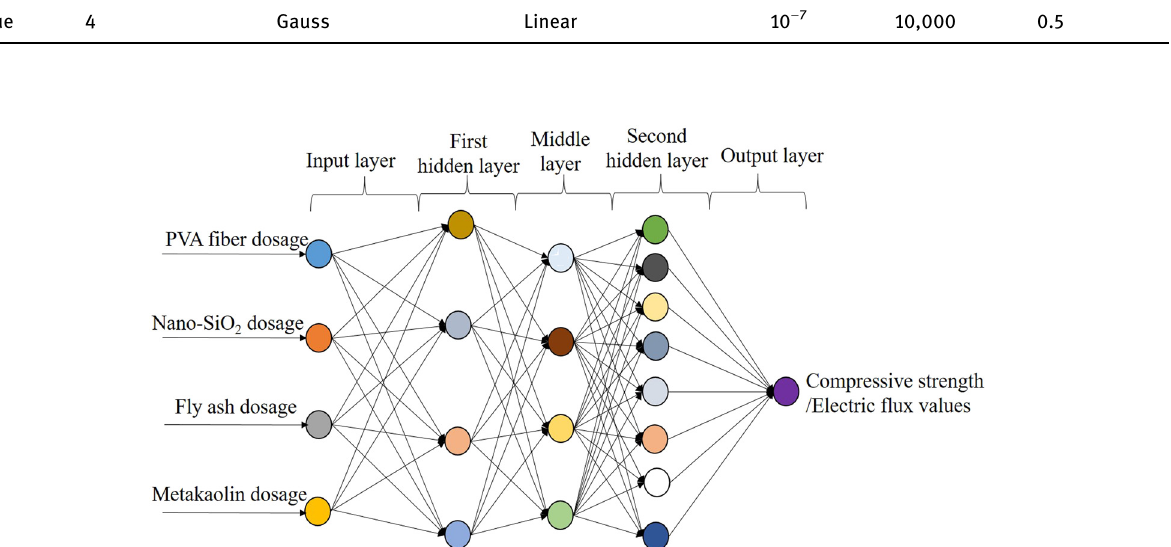
Figure 3: Structure of RBF – BP composite neural